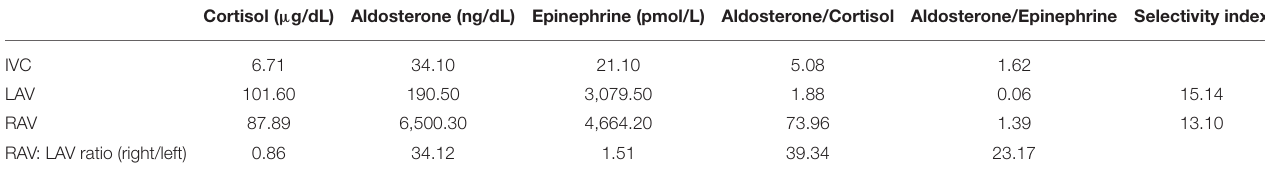
TABLE 3 | Results of adrenal venous